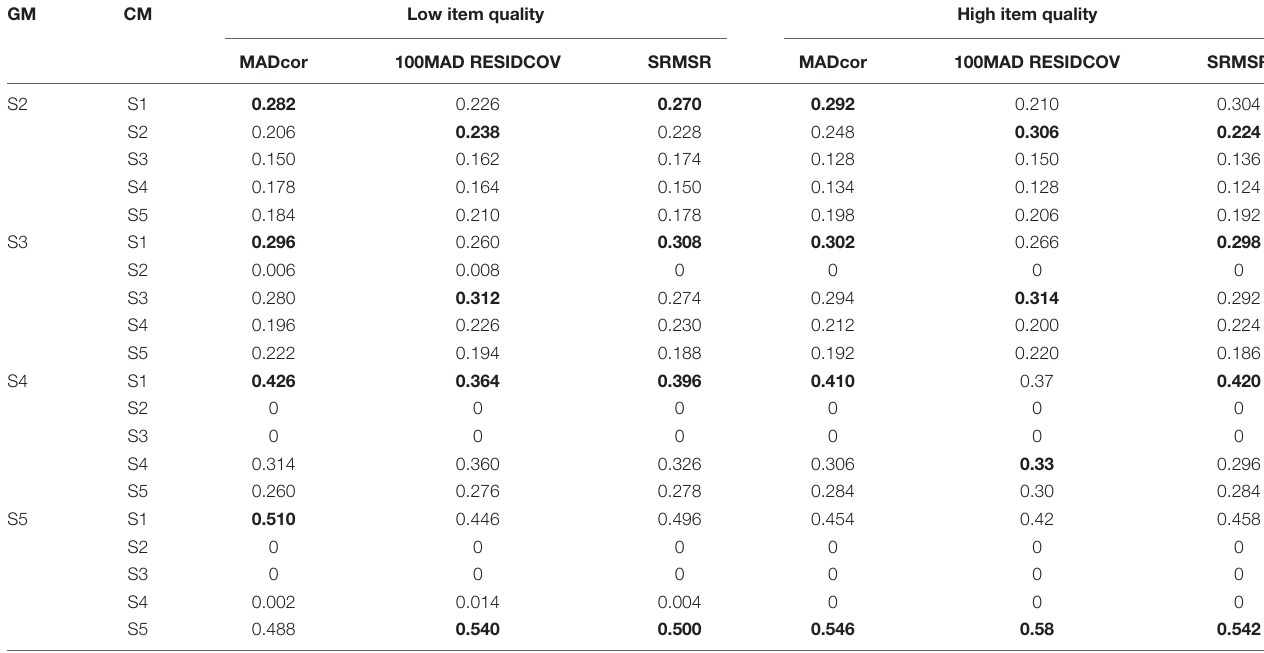
TABLE 7 | CDRs of AFIs for different hierarchical attribute structures. GM CM Low item